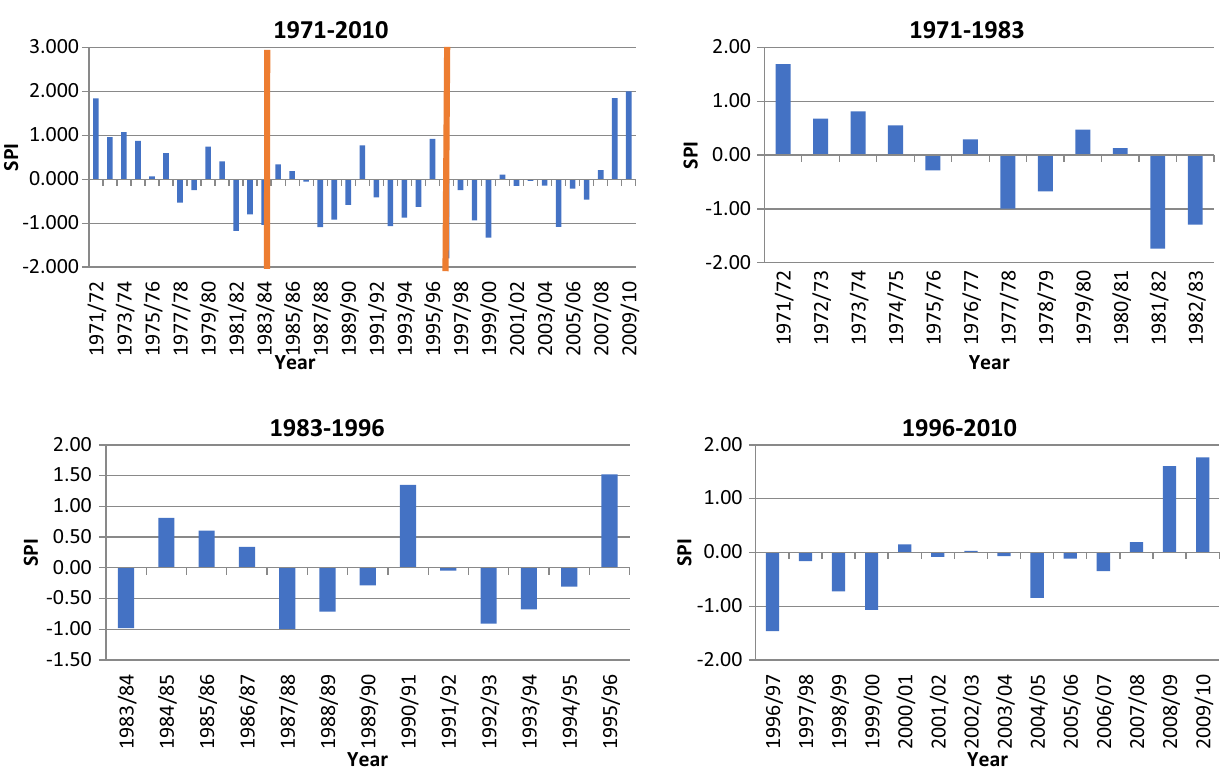
Fig. 7 Temporal evolution of SPI annual mean values at the six stations during the 1971–2010 period and the selected sub-periods Table 3 Rates (in %) of occurrence of climate conditions during the periods whole series of observations